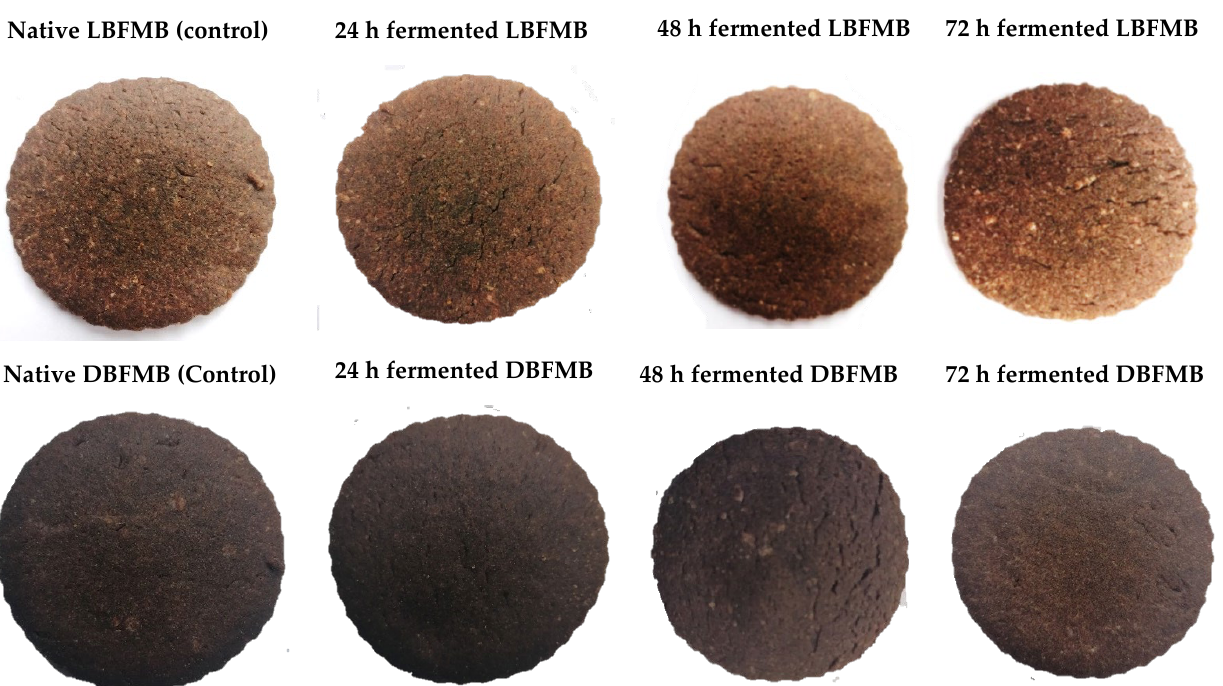
Figure 1. Images of finger millet biscuits. LBFMF = light brown finger millet biscuit, DBFMB = dark brown finger millet biscuit. Table 4. Influence of spontaneous fermentation on the colour attributes of finger millet biscuits.